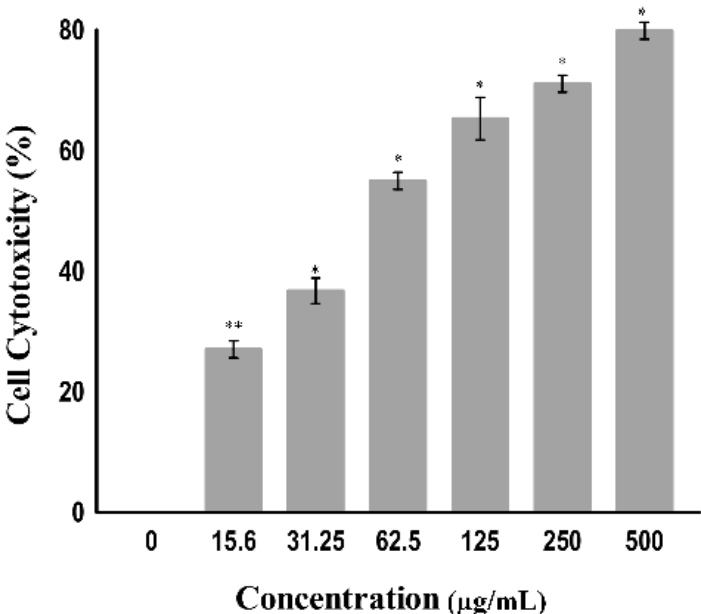
Figure 5. The cytotoxicity of the copper – Schiff base complex toward A549 cells using the LDH assay according to concentration. Data are expressed as the mean ± SD ( n = 3). * p < 0.05; ** p < 0.01.